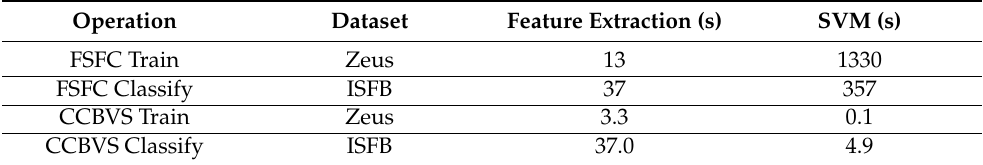
Table 16. Zeus/ISFB Dataset Run-Time Comparison.